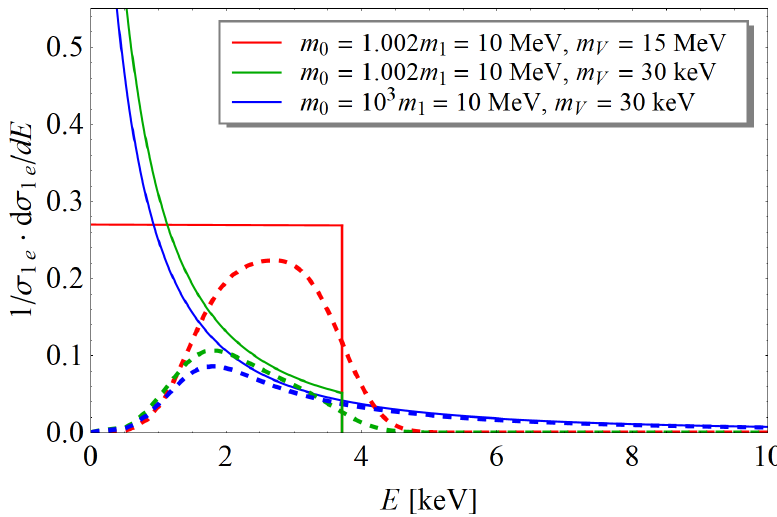
Figure 2 . Unit-normalized electron recoil energy spectra (solid lines, i.e., E is read off as E r ) in the VF case for three sets of mass values as shown in the legend. BDM and the mediator are a Dirac fermion and a massive vector. The dashed lines (i.e., E is read off as E obs corresponding plots with detector resolution ( σ and ref. [1],